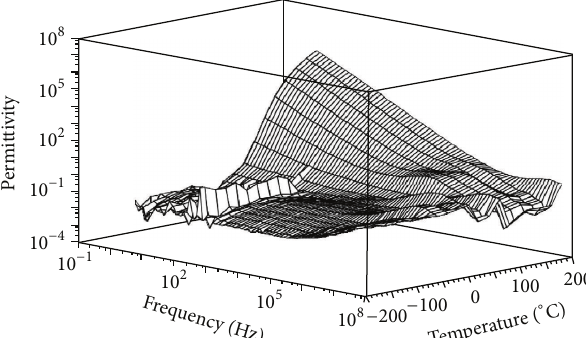
Figure 5: Dependence of thepermittivity of theepoxy polymer with carbon nanoporous microfiber (3% mass) from the temperature at the frequency range 1Hz–0.1 GHz.